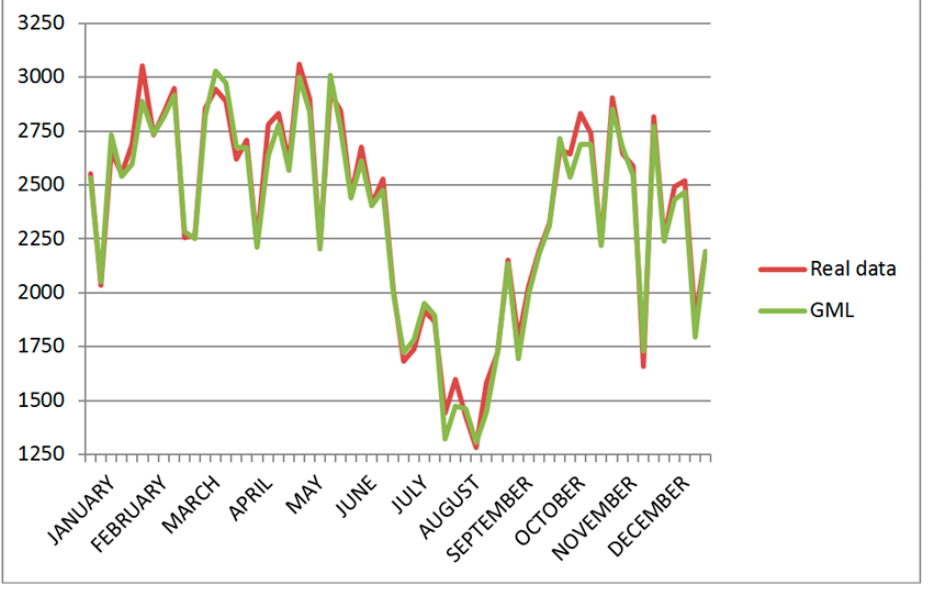
Figure 9. Comparison of the predictions of the weekdays with respect to the actual data of 2018.